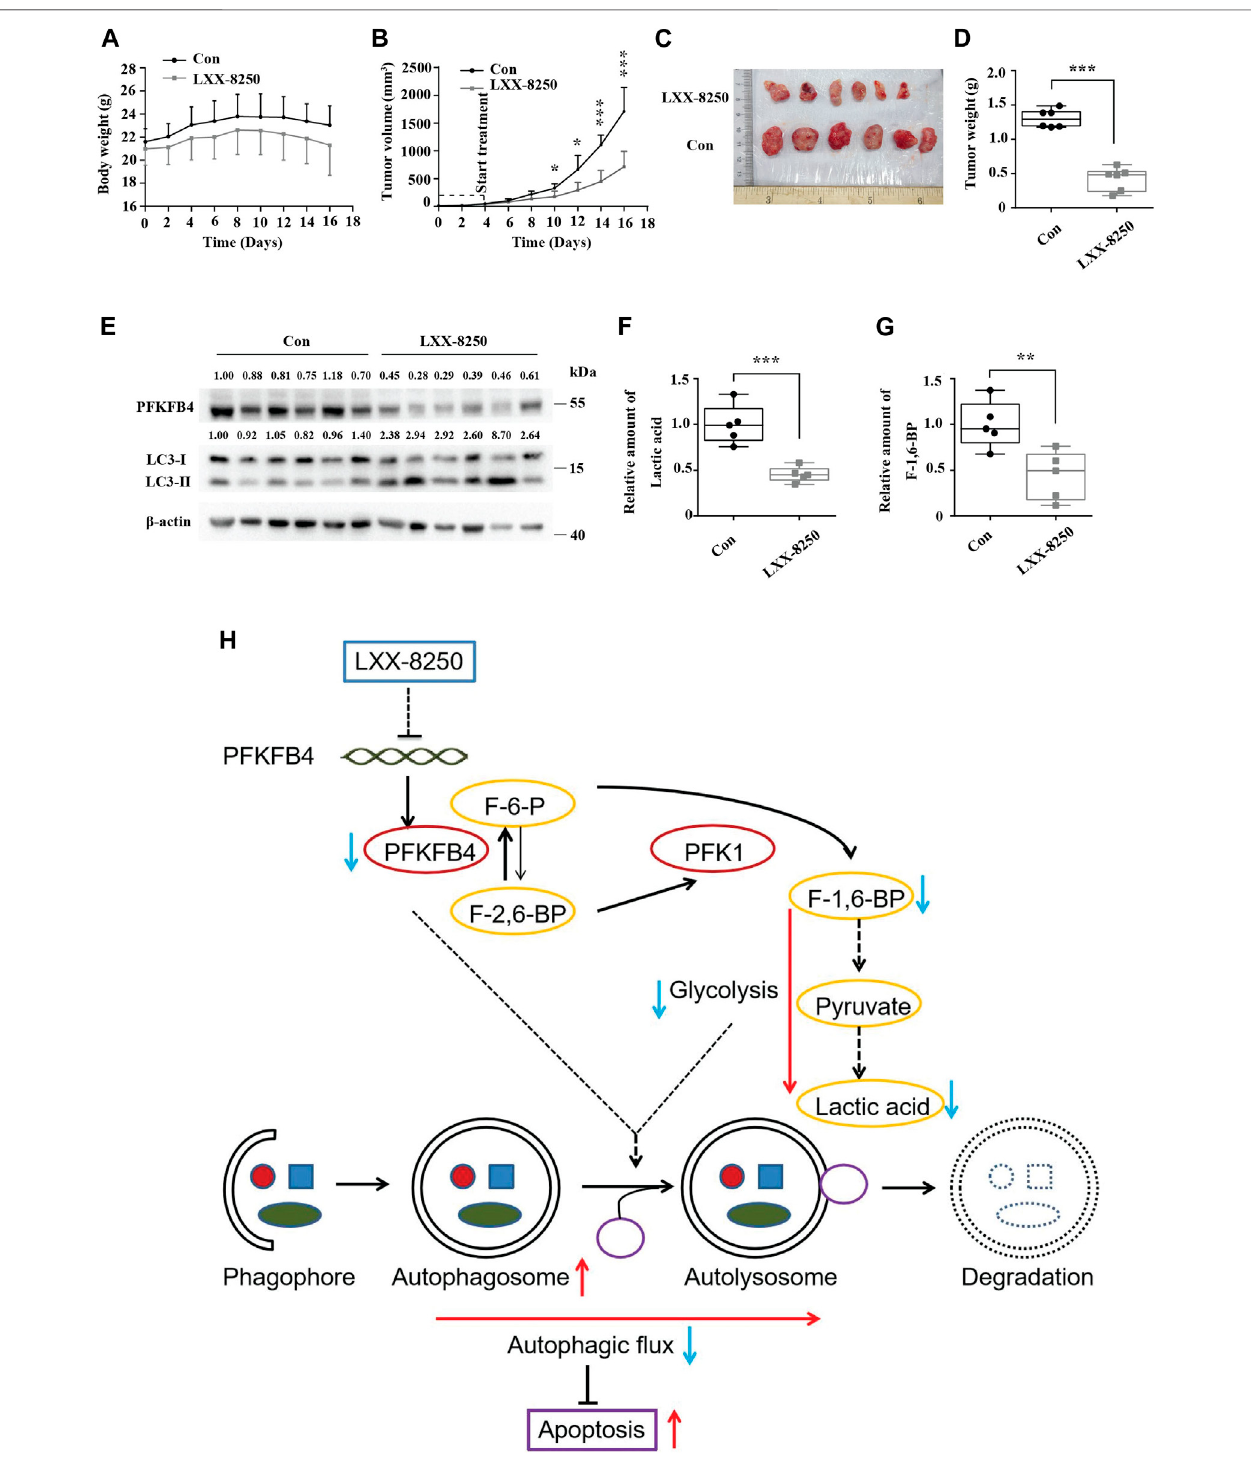
FIGURE 6 | Effects of LXX-8250 treatment on the growth of melanoma xenografts. The mice with A2058 xenografts were treated with LXX-8250 (20 mg/kg), and DMSOwasusedasacontroltreatment( n =6). (A) Every2 daysbodyweightsofmicewererecorded. (B) Every2 daystumorvolumeswererecorded. (C) Onday17,the tumorswereobtained.Picturesshownweretakenatthetimeofsacri fi ce. (D) Tumors ’ weightsweremeasured. (E) Westernblotanalysisforthetumortissuelysates.The quanti fi cation results of the band density (PFKFB4 and LC3-II) were labeled above the bands. (F) Lactic acid analyses for the tumor tissue lysates. (G) F-1,6-BP analyses for the tumor tissue lysates. (H) Schematic graph representing the working model of LXX-8250. F-6-P, fructose-6-phosphate; F-1,6-BP, fructose-1,6- biphosphate; F-2,6-BP, fructose-2,6-biphosphate. → , promotion; ┤ , suppression. Data represent mean ± SD. * p < 0.05, ** p < 0.01, *** p < 0.001.